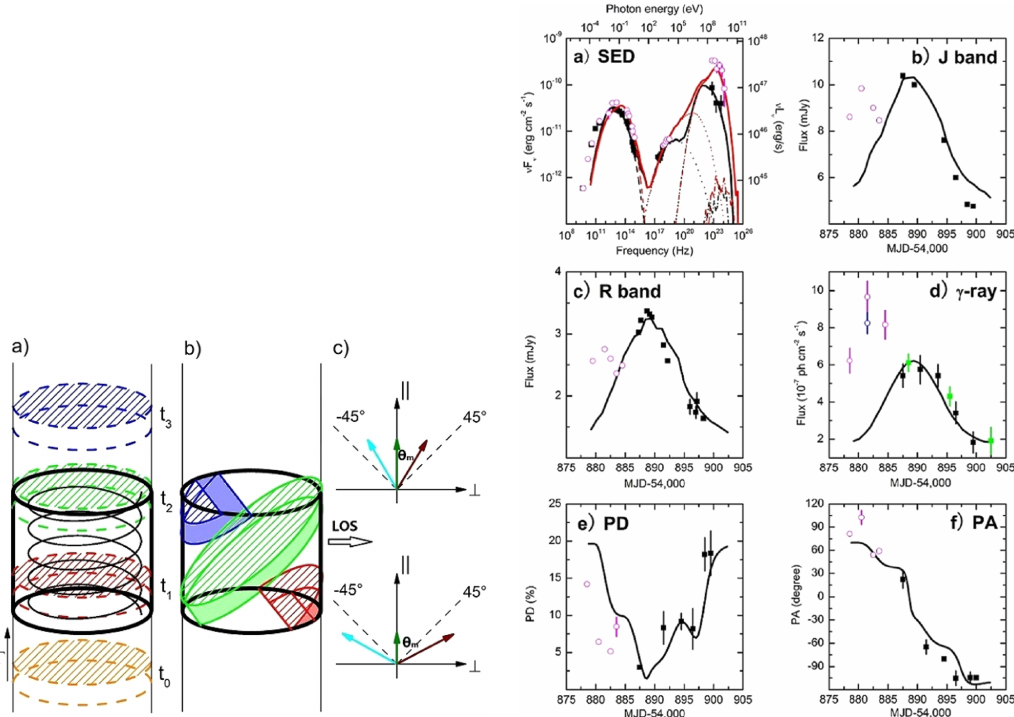
Figure 17. Left : Sketch of the magnetic-field geometry and illustration of light-travel-time effects in a shock-in-jet model with helical magnetic field. Different colors indicate the location of the shock front at different times: In the left-most sketch, equal times in the active galactic nuclei (AGN) rest frame; in the middle sketch: Location of the shock front at equal photon-arrival times at the observer, illustrating how different parts of a helical magnetic fields are “lit-up” by the shock front, as seen by the observer at different times, leading to a gradually changing dominant magnetic-field (and, thus, polarization) direction. Right : The resulting ( a ) snap-shot SEDs, ( b – d ) multi-wavelength light curves, ( e ) polarization degree, and ( f ) polarization-angle swing compared to observations of 3C279 by [58]. From [97]. Reproduced with permission from the American Astronomical Society